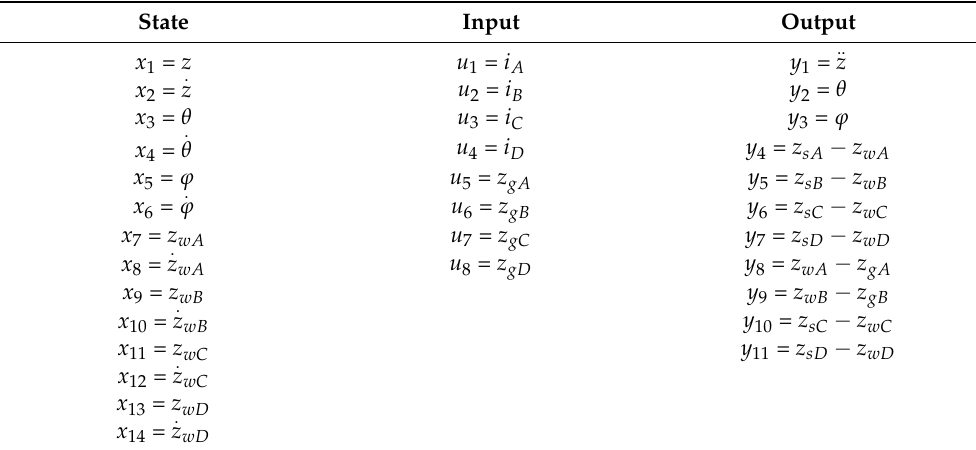
Table 2. State-input-output variables overview for full-car.